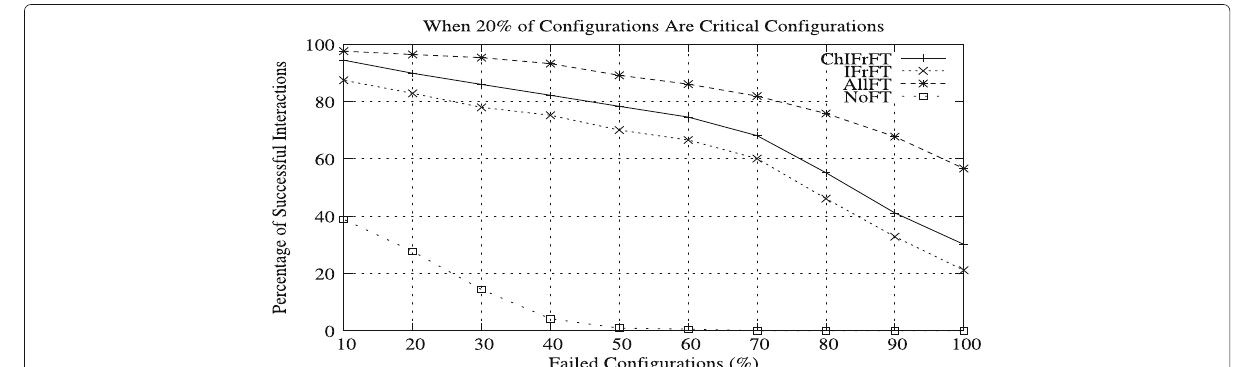
Fig. 12 Critical configurations are 20% of all configurations